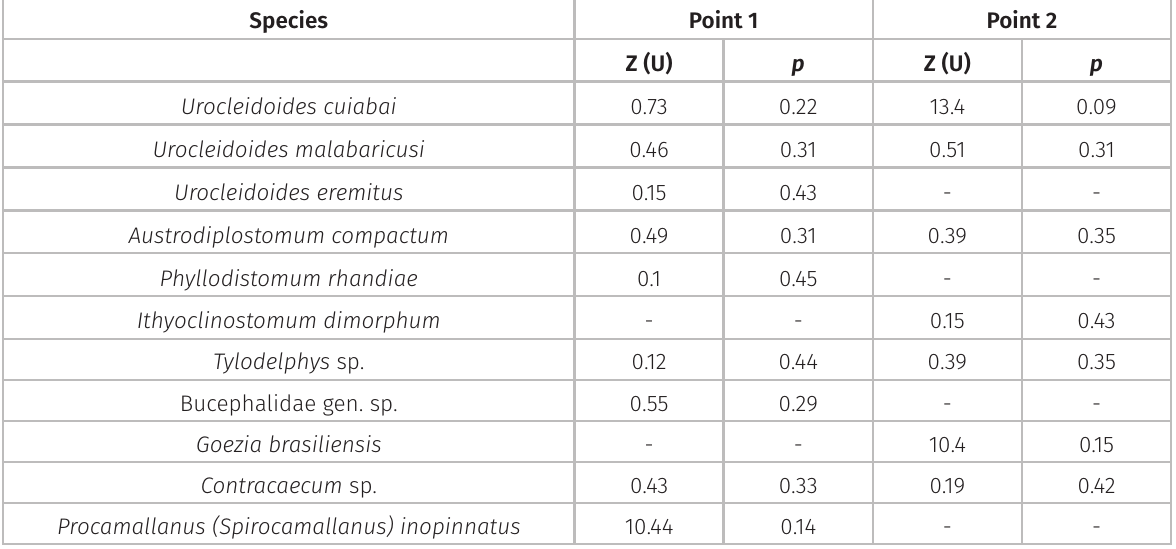
Table VI. Effect of the sex of the Hoplias malabaricus (Bloch, 1794) specimens collected between February 2014 and June 2016 at two points on the Batalha River in São Paulo State, Brazil, on the parasite abundance of each parasite species.